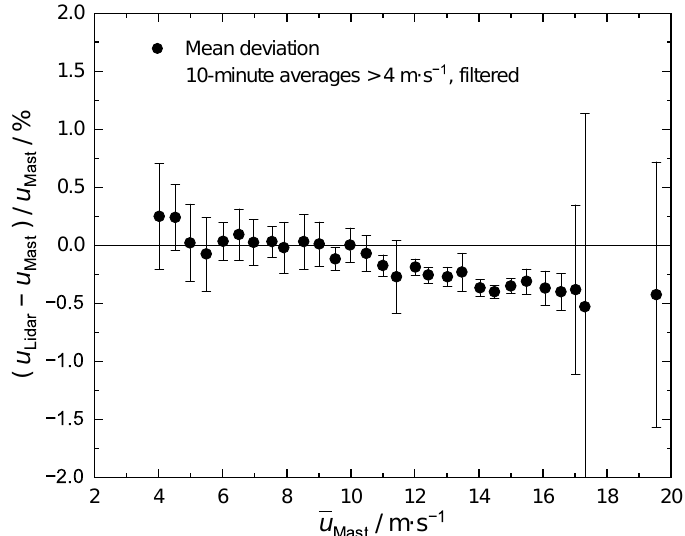
Figure 16. Results of the 2020 comparative measurement between the PTB bistatic lidar and a cup anemometer mounted on top of a 200 m met mast, evaluated according to IEC 61400-12-1 using filtered 10 min averages. Both instruments show good agreement with mean deviations between + 0.25% and − 0.5% over a large range of wind speeds.